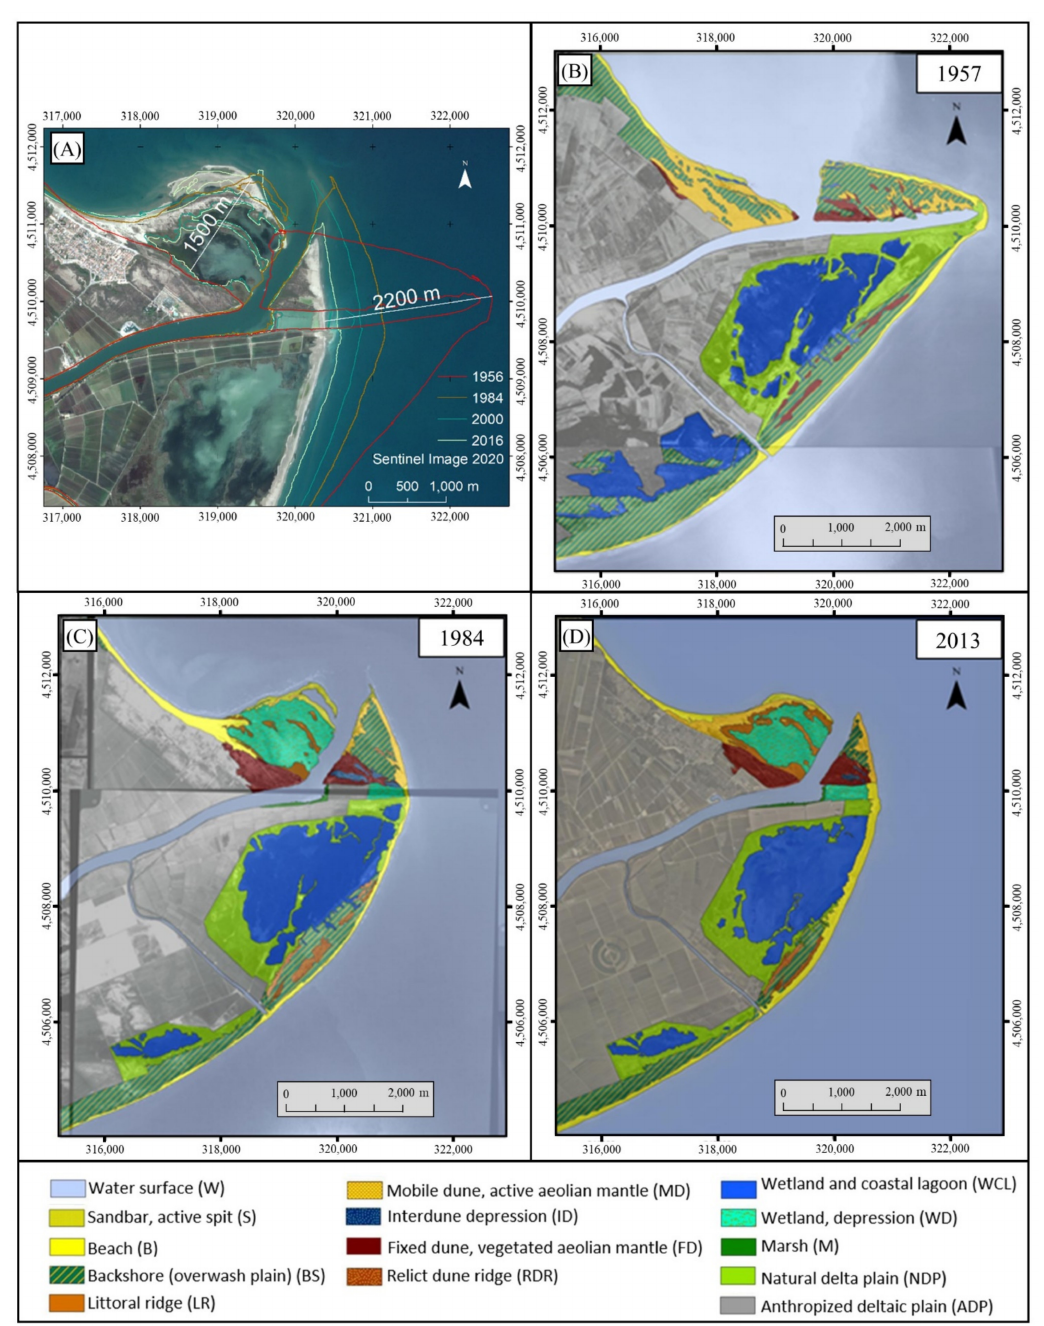
Figure 2. ( A ) Coastal evolution of Ebro River mouth (coastal lines on Sentinel image T31TCF_20201101T105209_TCI). ( B – D ) Geomorphological features evolution, reproduced from Ram í rez-Cuesta et al.